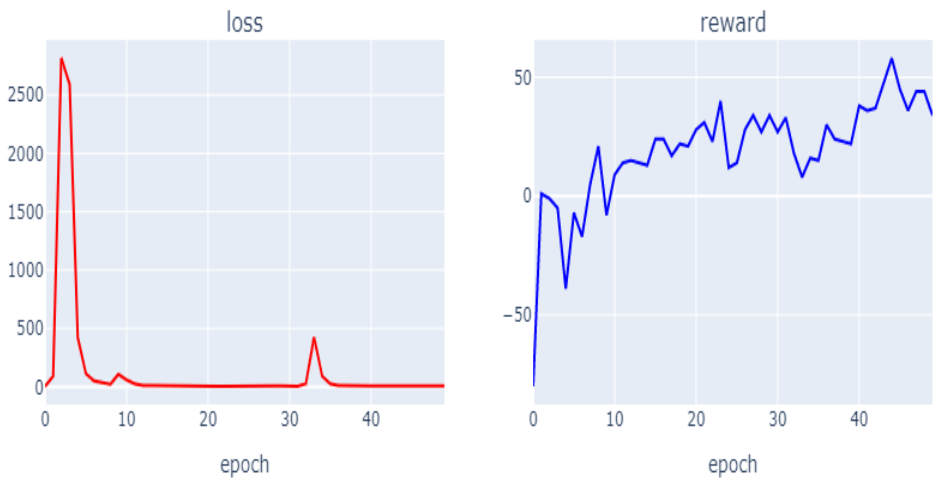
Figure 13. Learning results by substituting the Double Dueling DQN algorithm based on the proposed Total Resource on